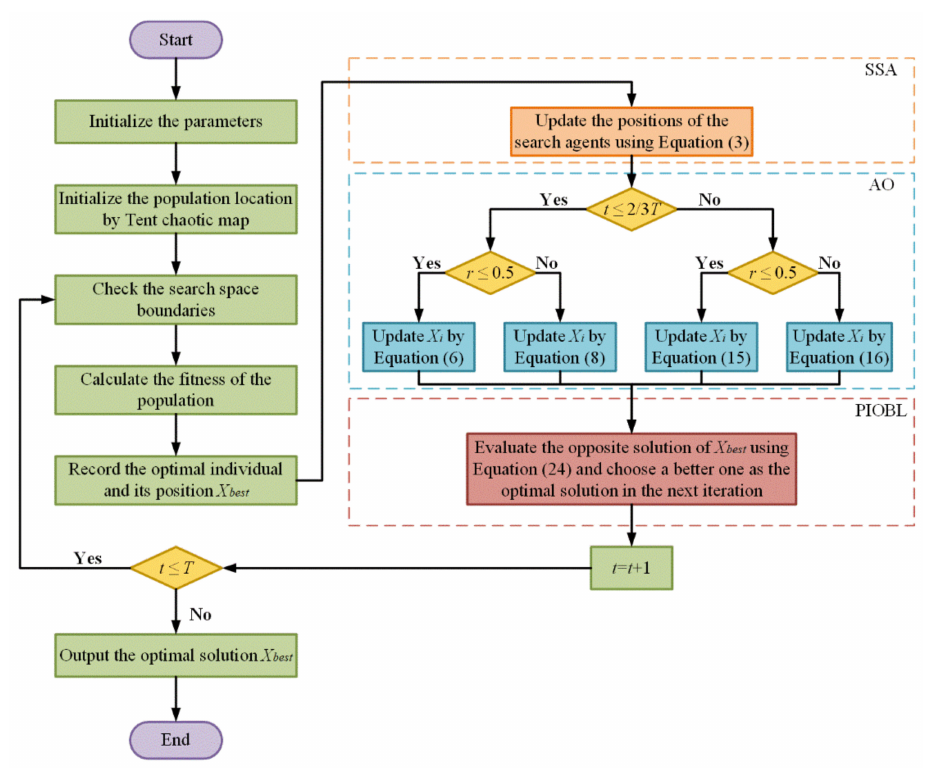
Figure 4. Flow chart of the proposed